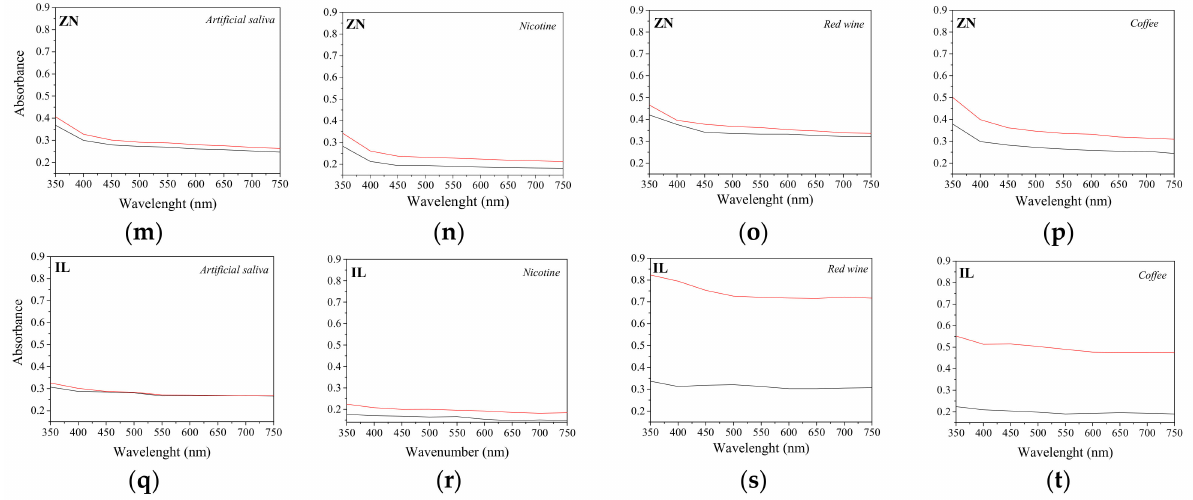
Figure 7. Absorbance curves of the aligners before (black line) and after (red line) 14 days of immersion in staining agents. ( a ) Erkodur (EK) in artificial saliva; ( b ) EK in nicotine; ( c ) EK in red wine; ( d ) EK in coffee; ( e ) Essix Plastic (EP) in artificial saliva; ( f ) EP in nicotine; ( g ) EP in red wine;